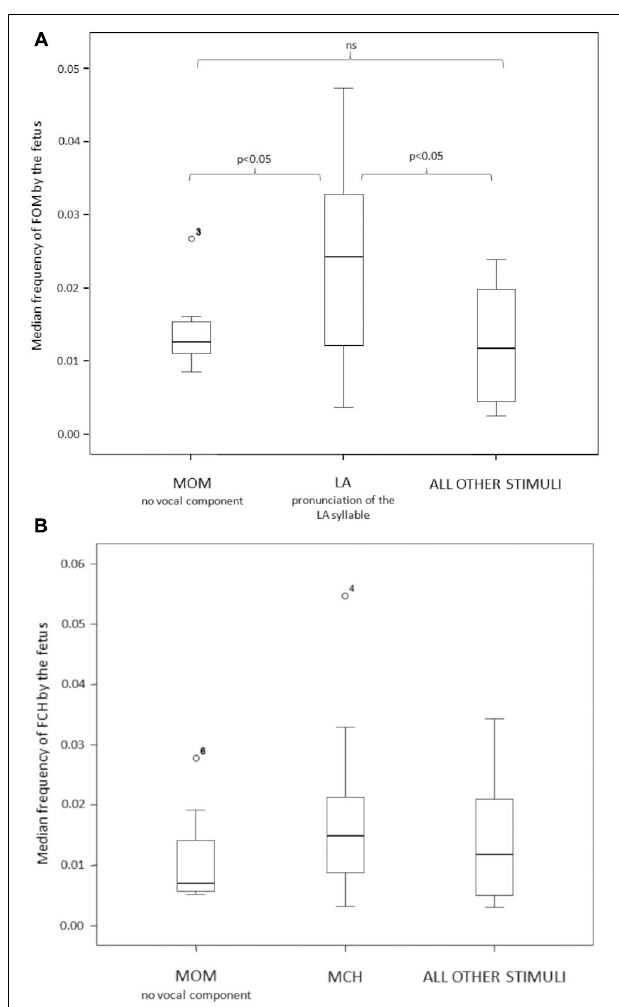
FIGURE 4 | (A) The open mouth (FOM) response of the fetus differed across the three stimulus conditions (LA, MOM, ALL OTHER). The fetus opened the mouth (FOM) more frequently when the mother sang the LA syllable in a nursery rhyme. (B) The chew response of the fetus (FCH) did not significantly differ as a function of the maternal stimuli proposed (MCH vs. MOM vs. ALL